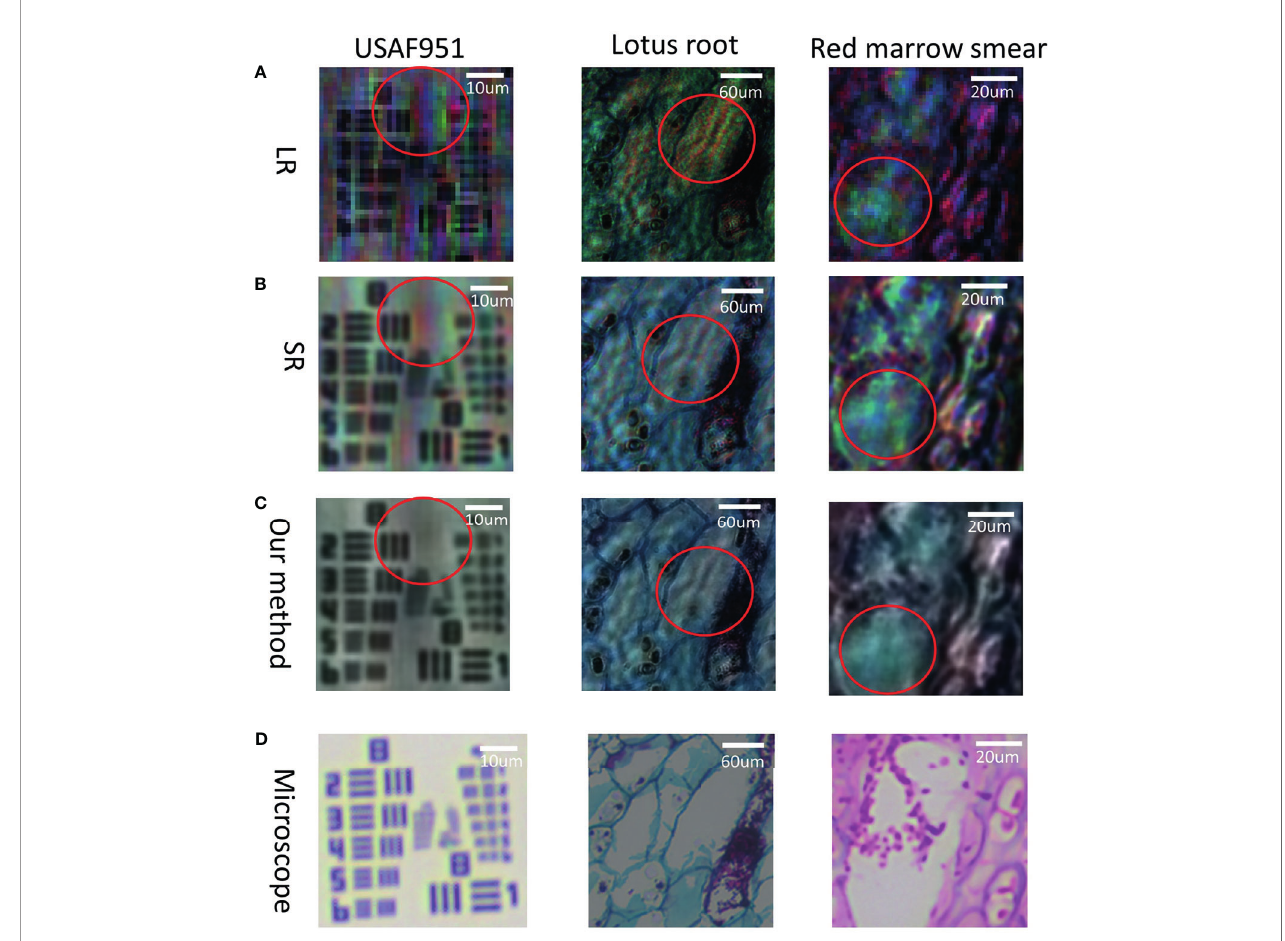
FIGURE 5 | Comparison results of the resolution chart, the lotus root cross section, and the red marrow smear sample in different colour reconstruction modes along with the images taken under the microscope. (A) Low-resolution colour image without pixel super-resolution; (B) Colour image using wavelength scanning pixel super-resolution and phase retrieval; (C) Colour-reconstructed image proposed in this paper; (D) Colour images taken by